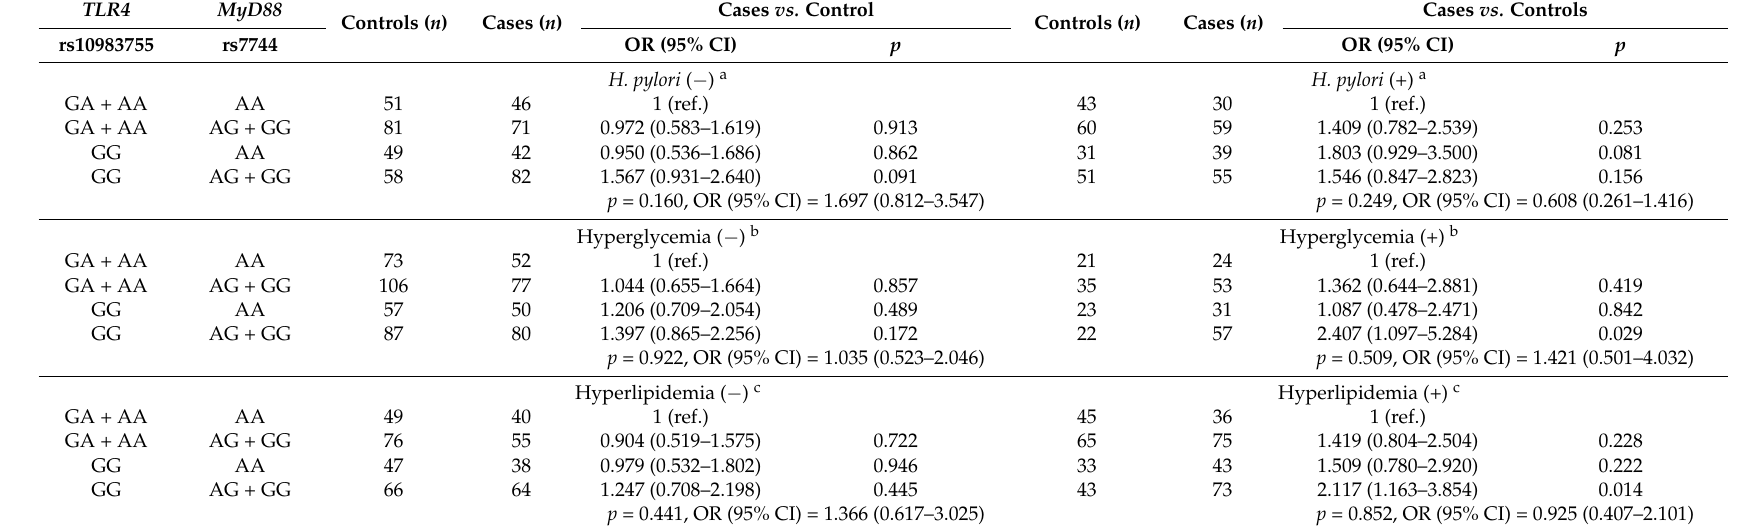
Table 5. The effect of confounding risk factors on the interaction between TLR4 rs10983755 and MyD88 rs7744 in the risk of CAD. TLR4 MyD88 Cases vs. Control Cases vs. Controls Controls ( n ) Cases ( n ) Controls ( n ) Cases ( n ) OR (95% CI) OR (95% CI) p H. pylori ( ´ )